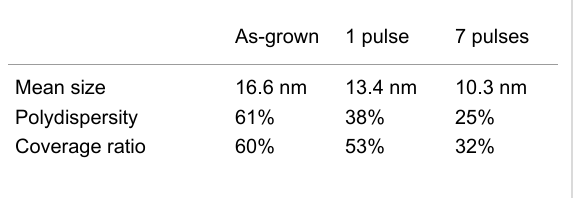
Table 1: Evolution of the NPs mean size, polydispersity, and coverage ratio as a function of the number of laser